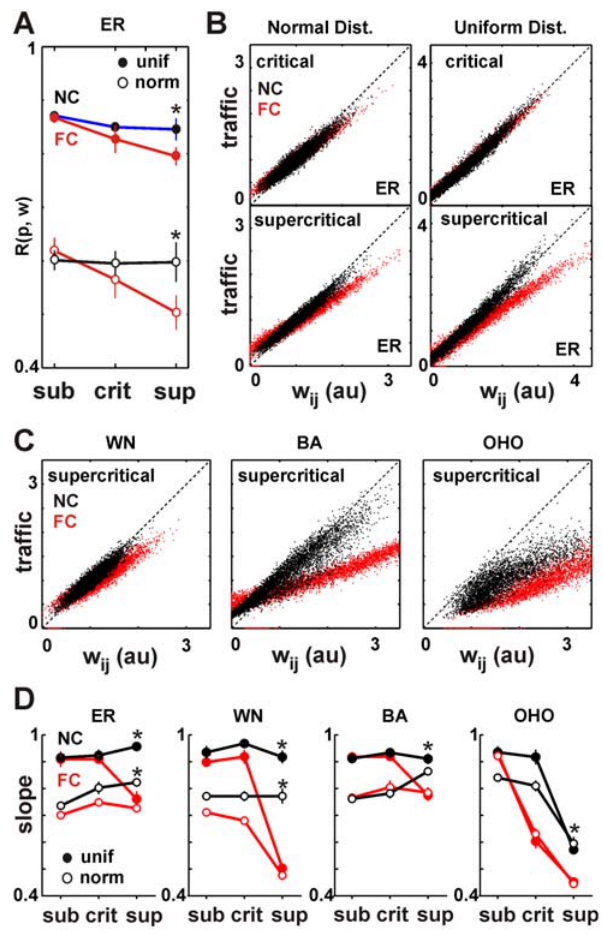
Figure 6. NC improves the reconstruction of the network traffic for different topologies and critical and supercritical dynam- ical regimes. (A) NC significantly improves the estimation of link activation probability p ij based on link traffic w ij . Correlation between p ij and w ij R p , w ð Þð Þ plotted for all three dynamical regimes. The mean and SD for each point were obtained from 10 network realizations. The figure indicates significant improvement by NC over FC for uniform (unif) and normal (norm) distributed p ij (ER network). (B) NC accurately estimates link traffic w ij . Scatter plot of w ij vs. actual traffic for each link for critical and supercritical regimes and two different link activation probability distributions. Note that w ij as estimated by NC (black dots) are located along the diagonal (broken line) indicating correct estimates of local traffic (n=10 networks combined). (C) Same as in (B), plotted for WN, BA, and OHO topologies in the supercritical regime with normally distributed p ij . (D) NC estimates the network traffic more accurately than FC. Slope of linear regression taken from analysis as shown in (B) and (C) for all topologies, two distributions, and three dynamical regimes. Note that the slope for NC is closer to 1, compared to FC in particular for the critical and supercritical regime. Reconstruction accuracy is low for OHO in the supercritical regime ( S k d T ~ 10, z ~ 1 , 20% noise). Results taken after N p ~ 80000 .